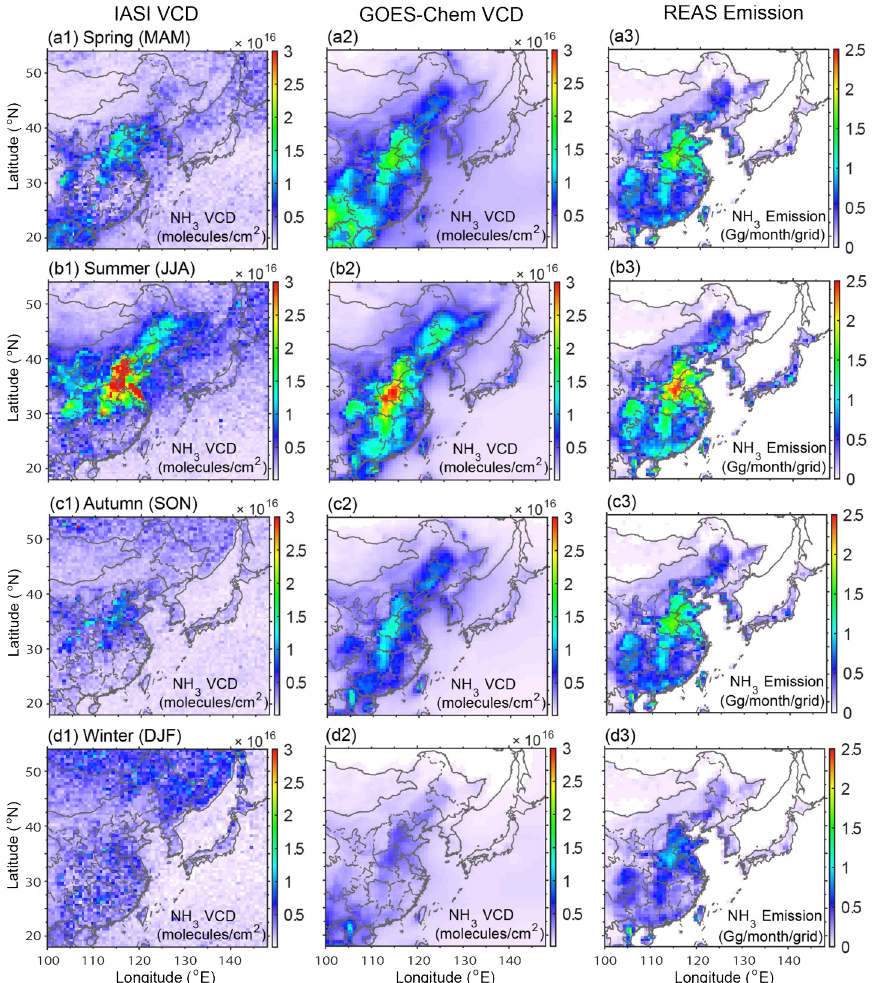
Figure 3. Horizontal distribution of seasonal averaged IASI retrieved ( a1 – d1 ) and GEOS-Chem simulated ( a2 – d2 ) NH 3 VCDs as well as REAS NH 3 emission ( a3 – d3 ) over East Asia.